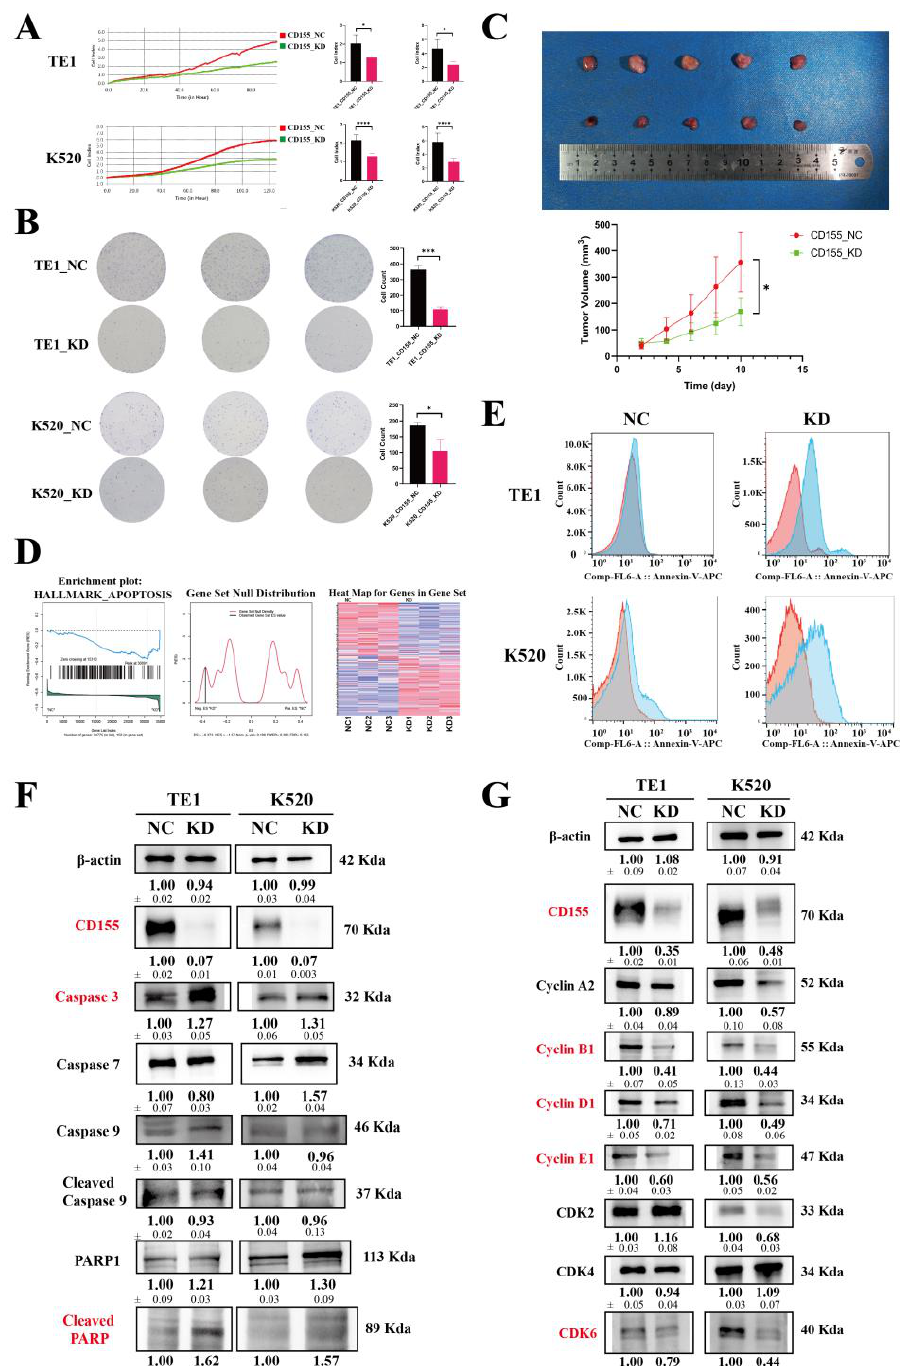
Figure 8. The downregulation of CD155 inhibits ESCA cells’ proliferation by inducing cell cy- cle S phase arrest and cell apoptosis. ( A ) Real-time cell analyzer, ( B ) colony formation assays, and ( C ) in vivo experiments were performed to validate the proliferation between CD155_NC and CD155_KD groups in TE1 cells and K520 cells. These cells showed increased levels of cell apoptosis, supported by ( D ) GSEA analysis from RNA-seq ( E ) cell apoptosis flow analysis, and ( F ) Western blotting revealed a higher level of caspase 3 and cleaved PARP in the CD155_KD group of TE1 and K520 cells. Moreover, ( G ) Western blot indicated that the downregulation of CD155 may induce a decreased level of Cyclin B1, D1, E1, and CDK6 in TE1 and K520 cells. * p < 0.05; *** p < 0.001; **** p < 0.0001.The original WB Blots of subfigure ( F ) is Figure S7. The original WB Blots of subfigure ( G ) are Figure